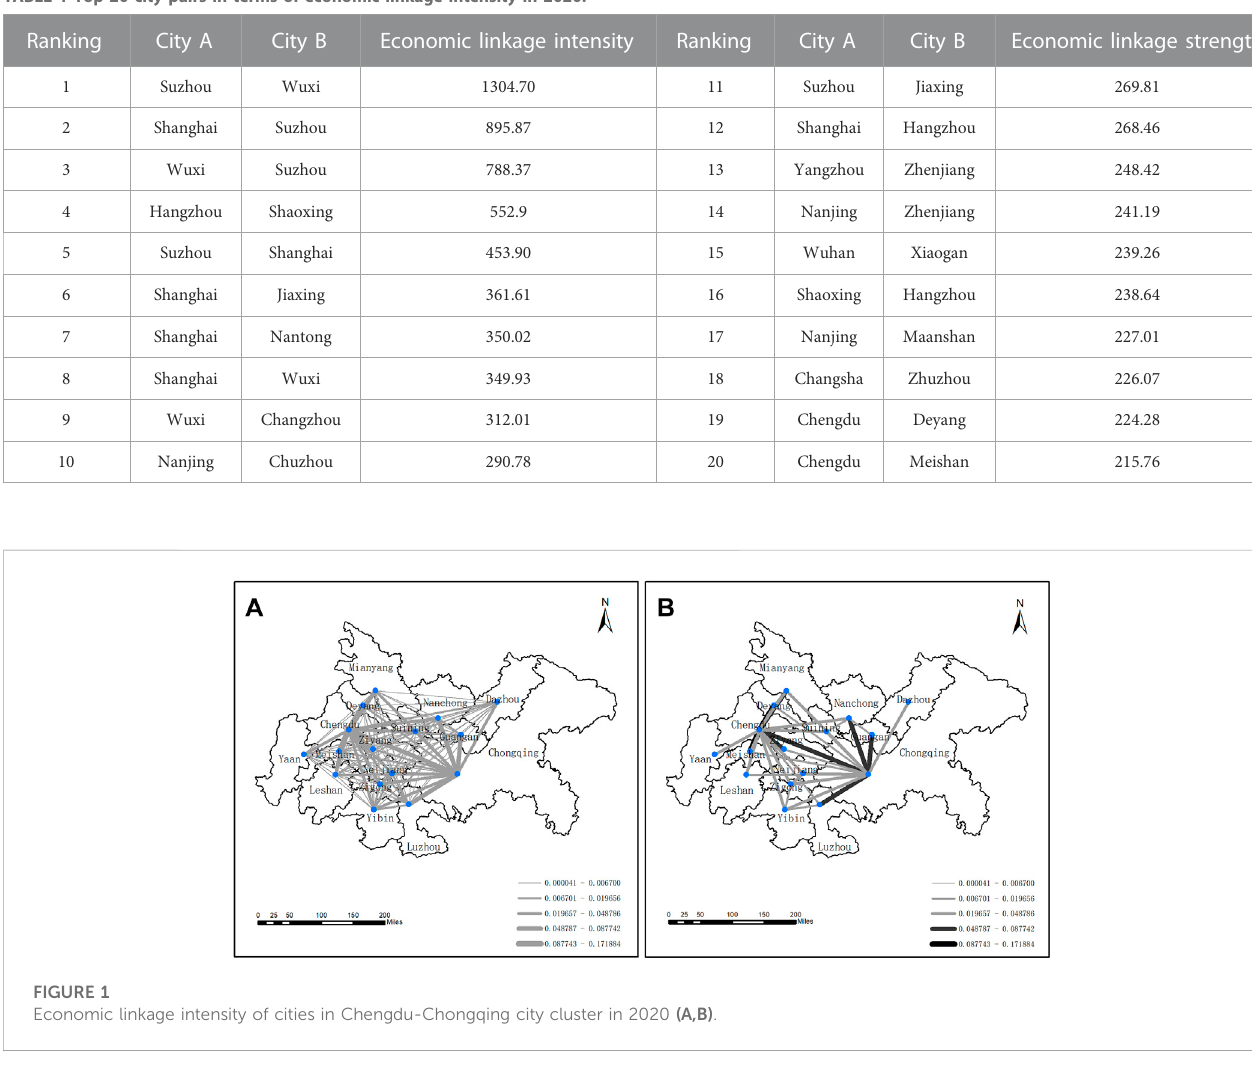
agglomeration, respectively, in 2020. Figure 1A, Figure 2A, and Figure 3A show all urban economic linkages, while Figure 1B, Figure 2B, and Figure 3B show the effects presented after excluding